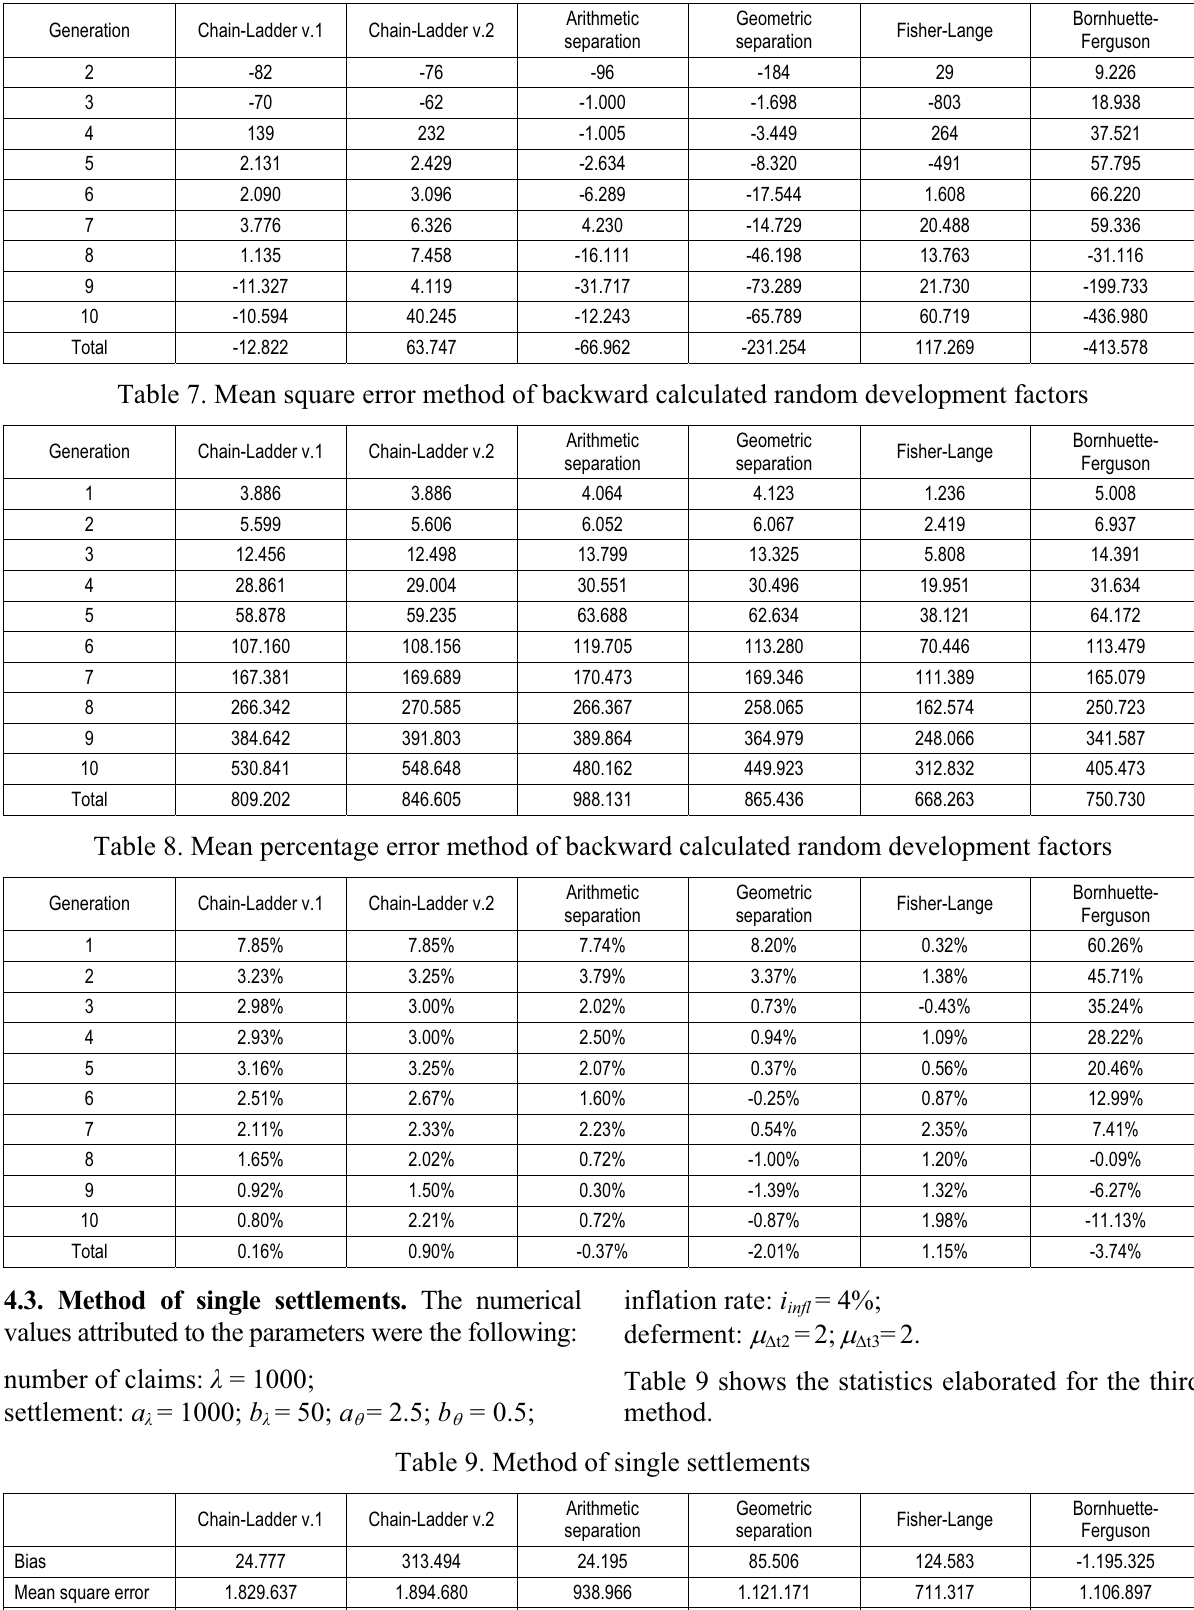
Table 6 (cont.). Bias method of backward calculated random development factors